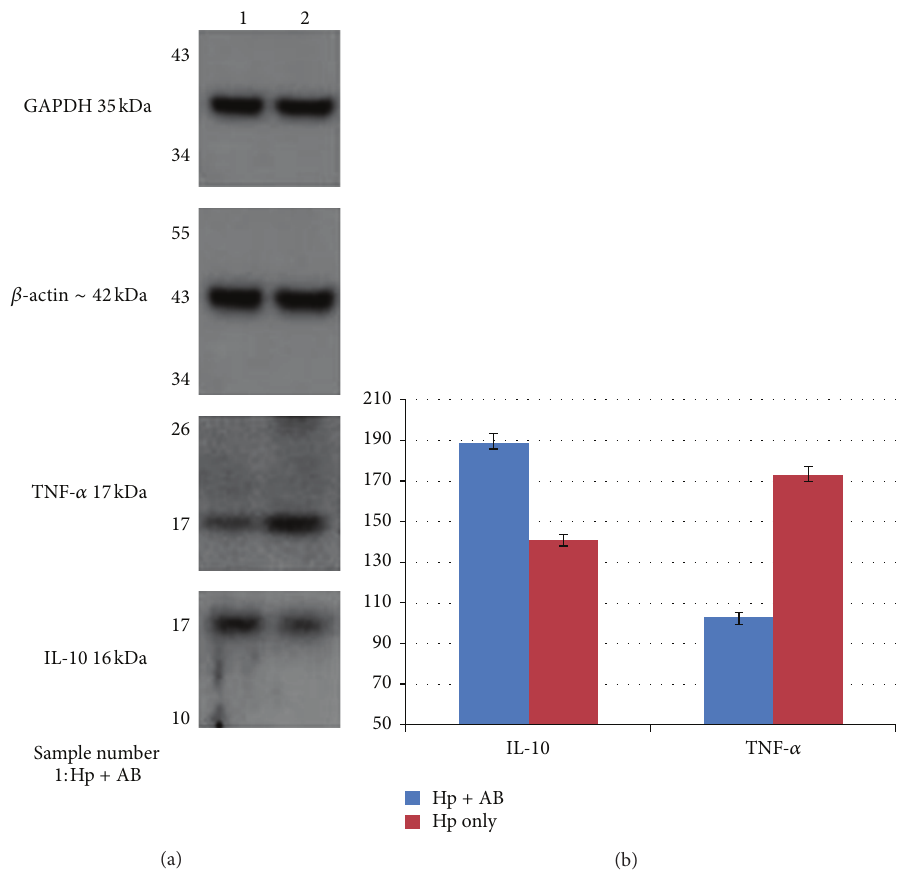
Figure 5: (a) The expression of different proteins in Groups D (AB + Hp) and E (Hp only) by Western blotting. (b) The different protein levels in yogurt-fed (Group D, Hp + AB) and control (Group E, Hp only) groups were shown. Data presented with mean ± SE. Two groups showed similar expression of GAPDH and 𝛽 -actin. We found that Group D had obvious higher IL-10 level ( 𝑃 = 0.0002 ) but lower TNF- 𝛼 level ( 𝑃 = 0.0002 ). Hp: Helicobacter pylori , AB: AB yogurt, IL-10: interleukin-10, TNF- 𝛼 : tumor necrosis